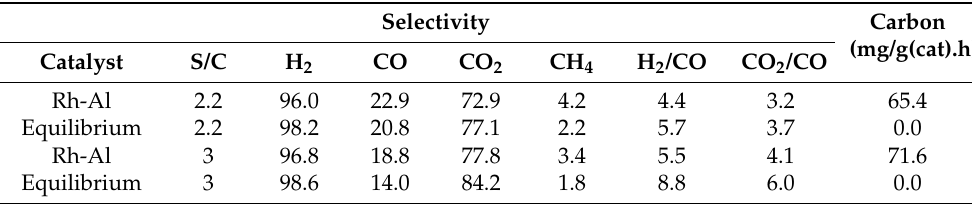
Table 8. Products selectivity and carbon formation for bio-oil surrogate ATR at 1 bar and S/C molar ratio of 2.2 and 3 (corresponding to reaction temperatures of 593 and 572 ◦ C, respectively). λ = 0.318 and 0.391 for S/C ratios of 2.2 and 3,